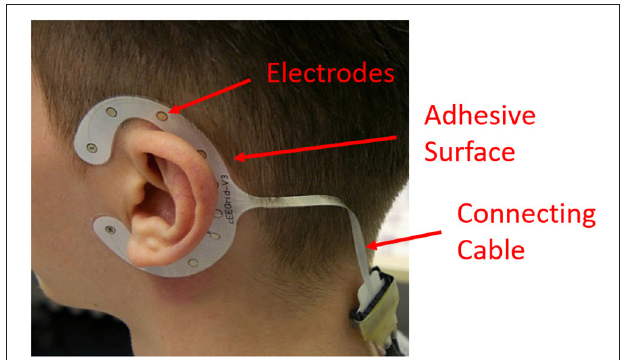
FIGURE 1 | cEEGrids technology, consisting of C-shaped electrode arrays with 10 electrodes placed around the participant’s left and right ears (photo: